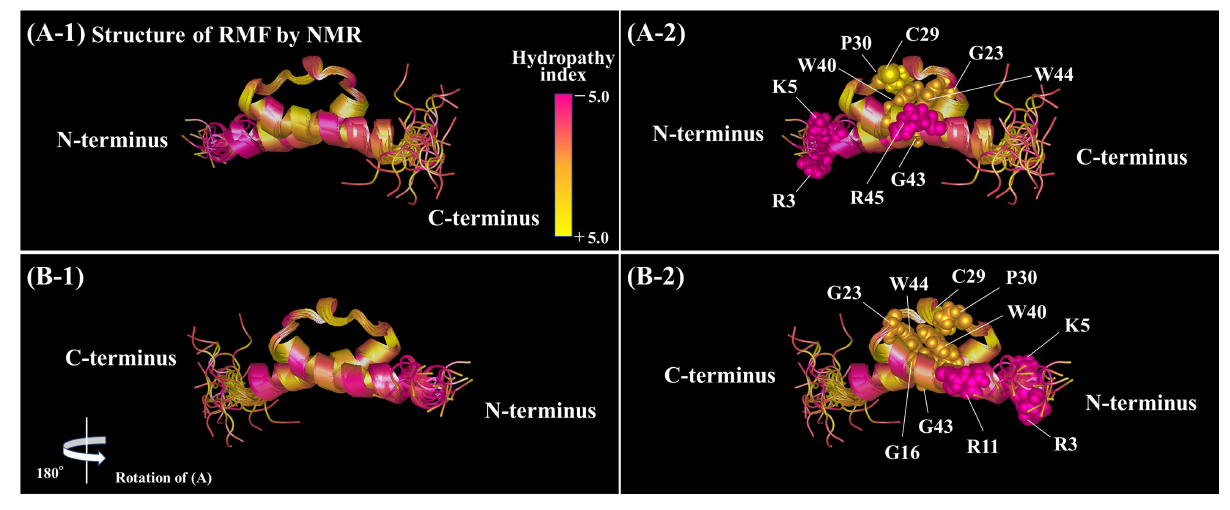
FIGURE 6 | Positions of the conserved amino acids in the structure of RMF from Vibrio parahaemolyticus (PDB ID: 2JRM). (A1,B1) Are shown in the ribbon model. In (A2,B2) , the conserved amino acids are displayed by the ball model. (B) is (A) rotated by 180 ◦ with respect to the vertical axis. The colors represent the hydropathy index. (A1,B1) Rotated by 90 ◦ with respect to the horizontal axis are shown in Supplementary Figure 6